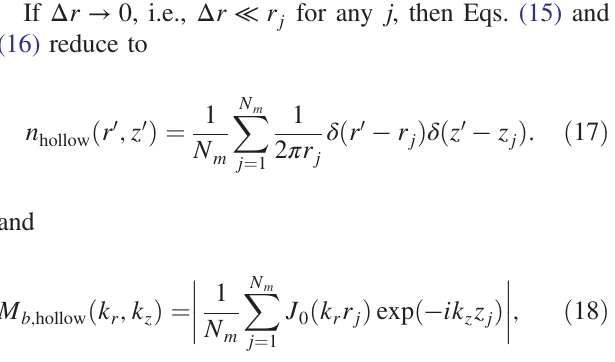
from our simulation (red curves) with cutoff beam radii at